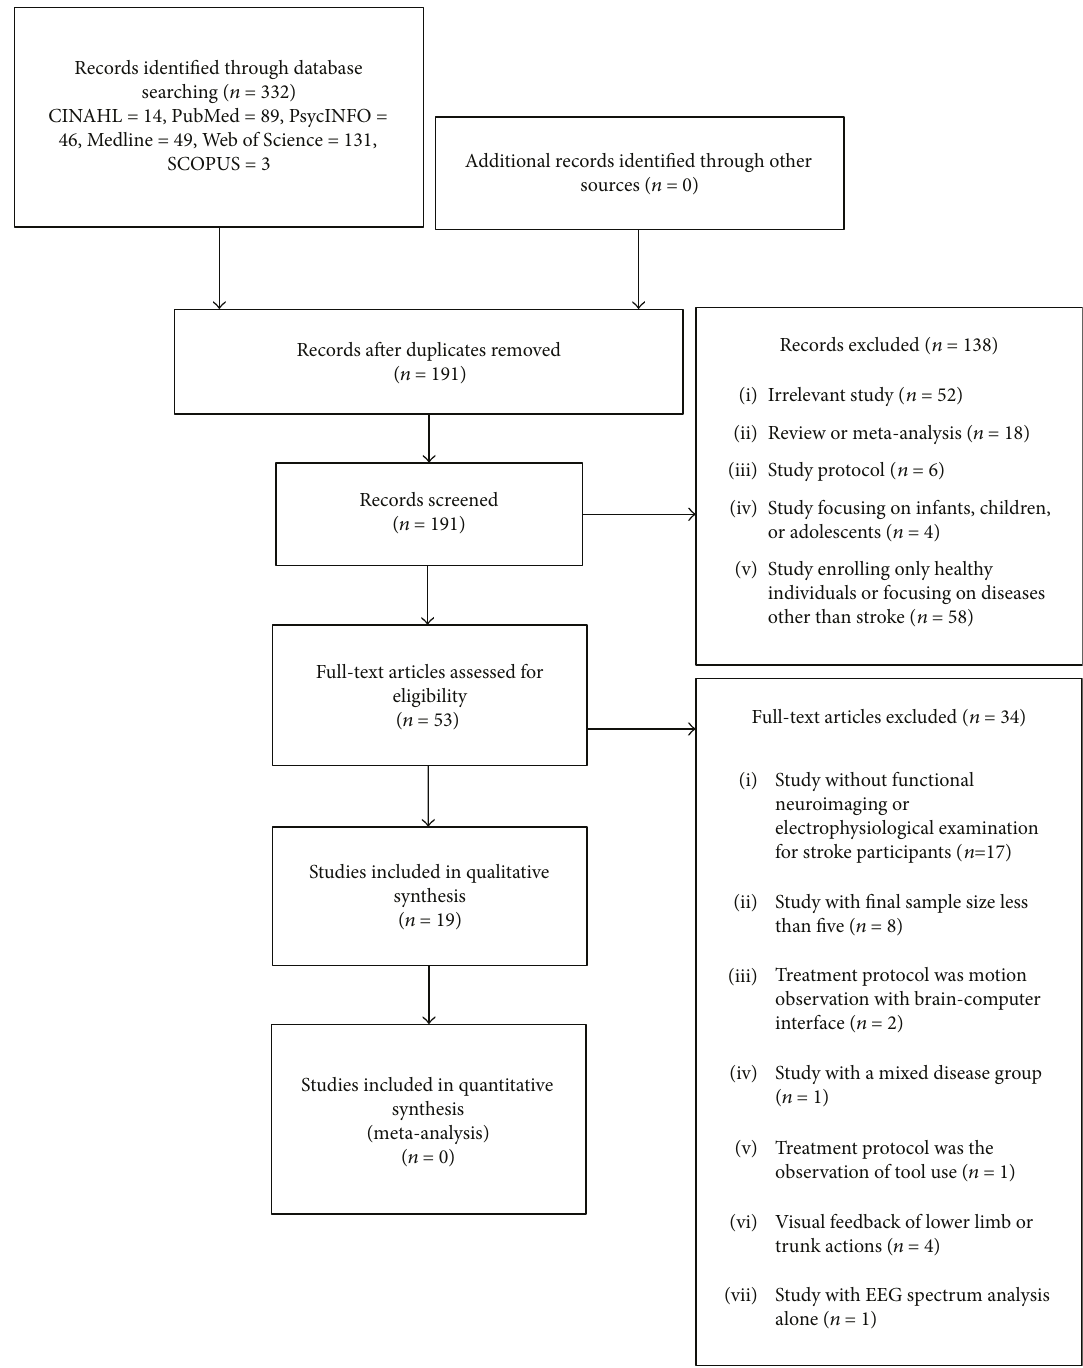
Figure 1: Flowchart of literature